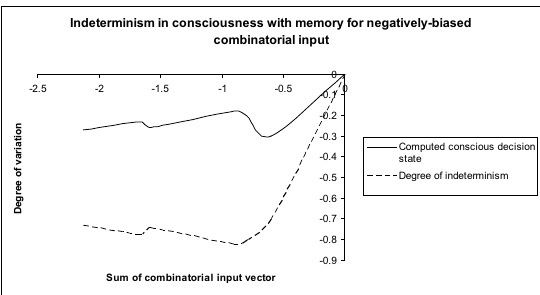
Fig. 22. Variation of state of consciousness in system with memory ( (cid:16) biased